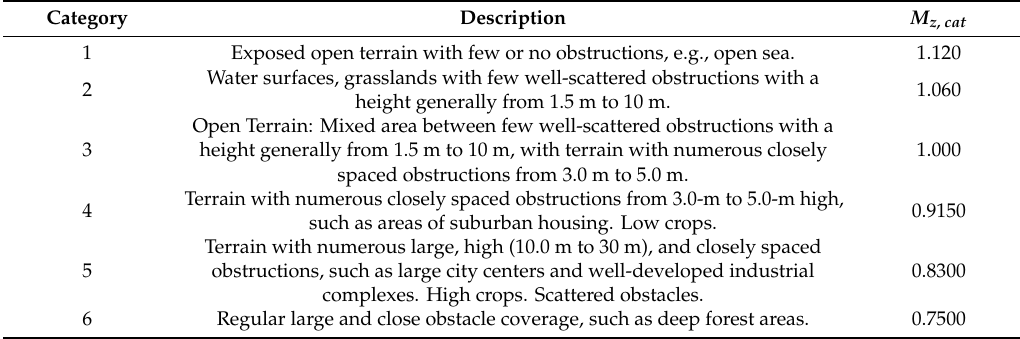
Table 4. Coe ffi cients and descriptions of the terrain categories.